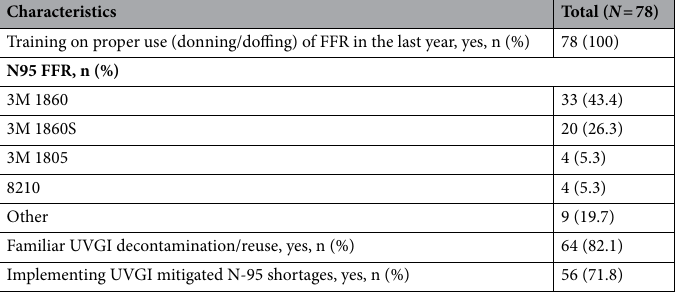
Table 2. N95 FFR